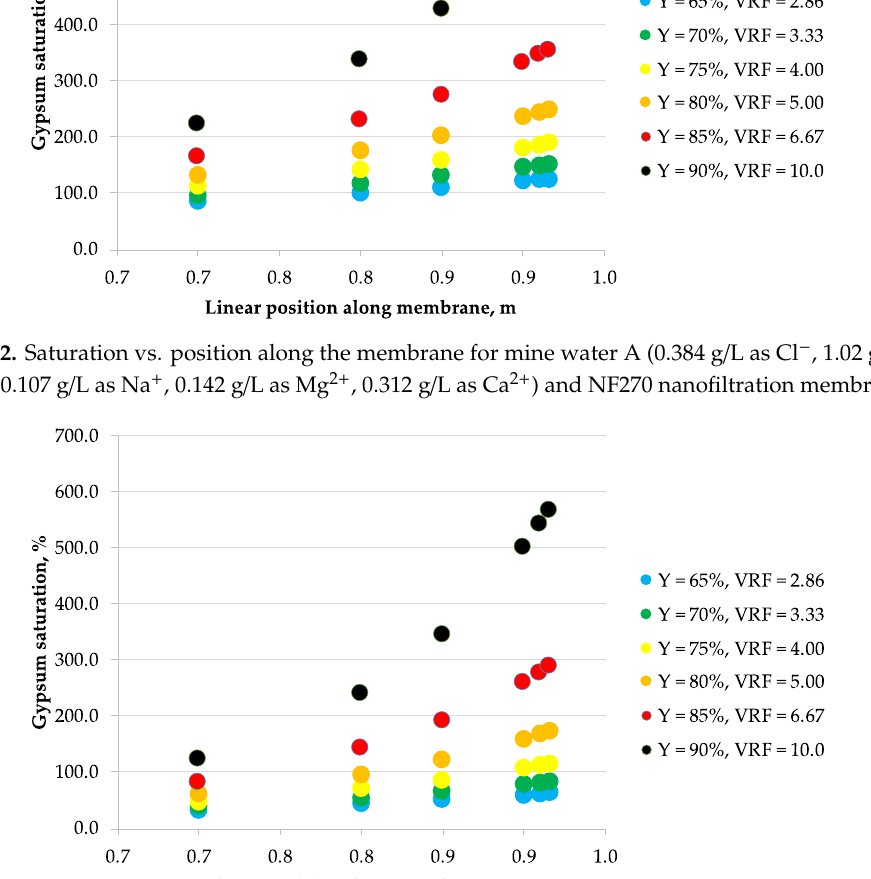
Figure 4. Saturation vs. position along the membrane for mine water A (0.384 g/L as Cl − , 1.02 g/L as SO 42 − , 0.107 g/L as Na + , 0.142 g/L as Mg 2+ , 0.312 g/L as Ca 2+ ) and NFX nanofiltration membrane.